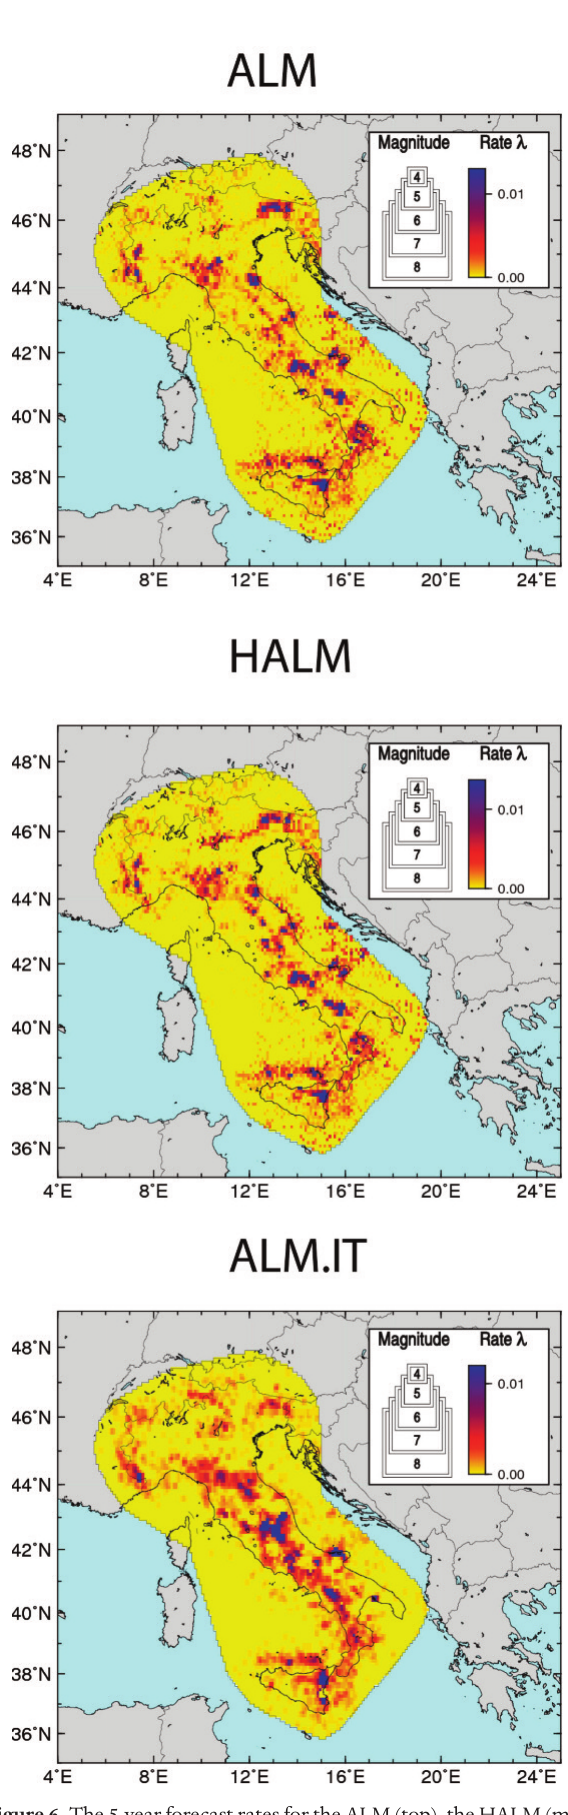
Figure 6. The 5-year forecast rates for the ALM (top), the HALM (middle) and the ALM.IT